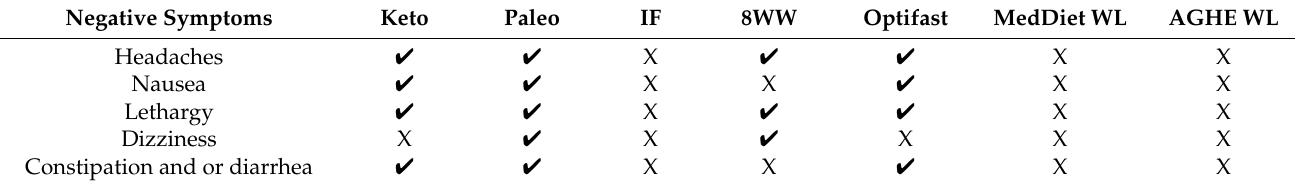
Table 3. Negative symptoms of popular weight loss diets and healthy eating principles extracted from their respective